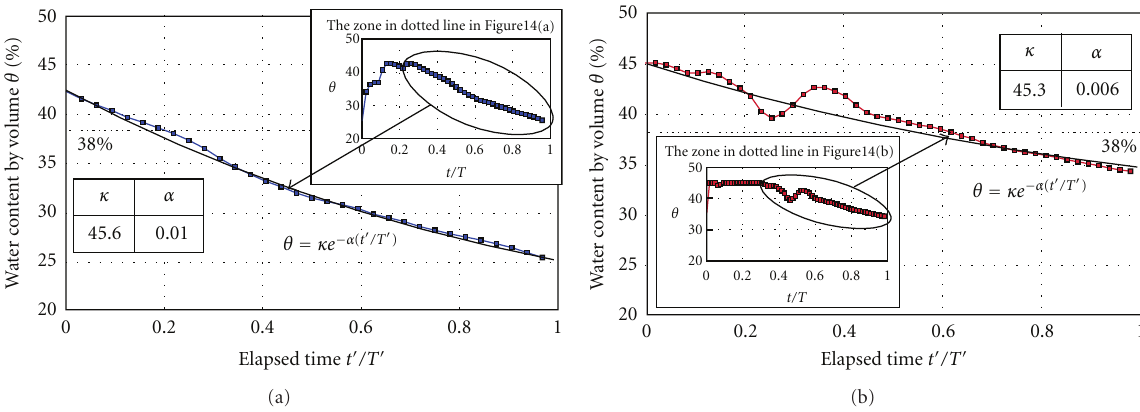
Figure 16: Relationship between water content by volume, θ , and normalized time, t (cid:5) /T (cid:5) , for drainage process and fitting curve proposed in this study; (a) in summer season, and (b) in winter